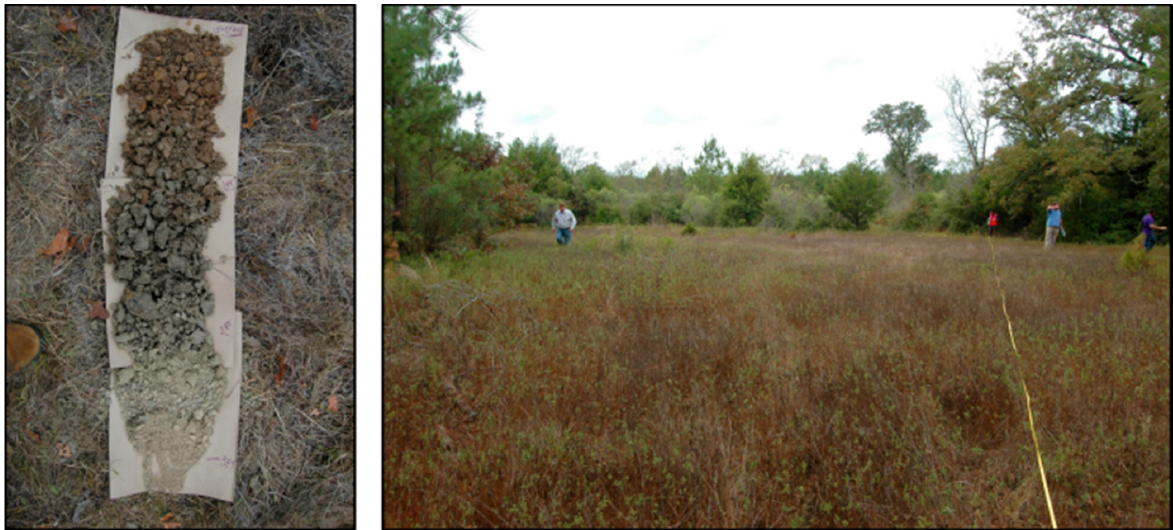
Figure 1. Project site photos taken prior to installation of treatments. Left = photo of soil profile; Right = site photo showing abundance of grasses on the site prior to installation.